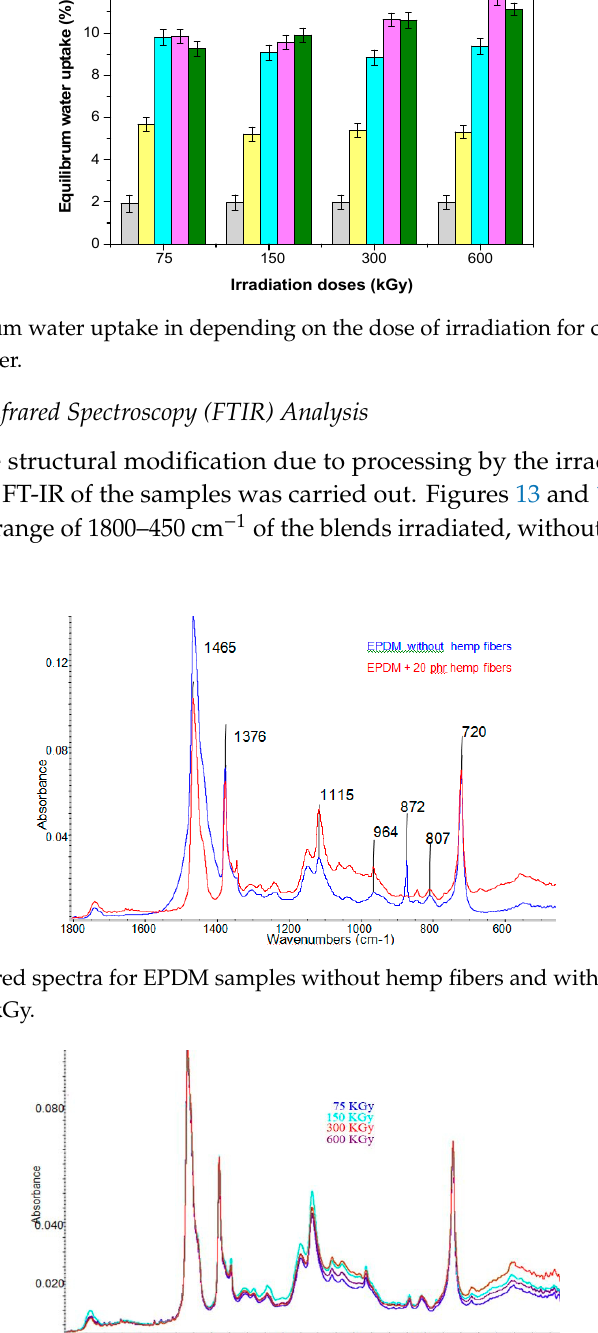
Figure 11. Water uptake of composites based on EPDM and hemp fiber versus immersion time for irradiation doses of ( a ) 75 kGy; ( b ) 150 kGy; ( c ) 300 kGy and( d ) 600 kGy.